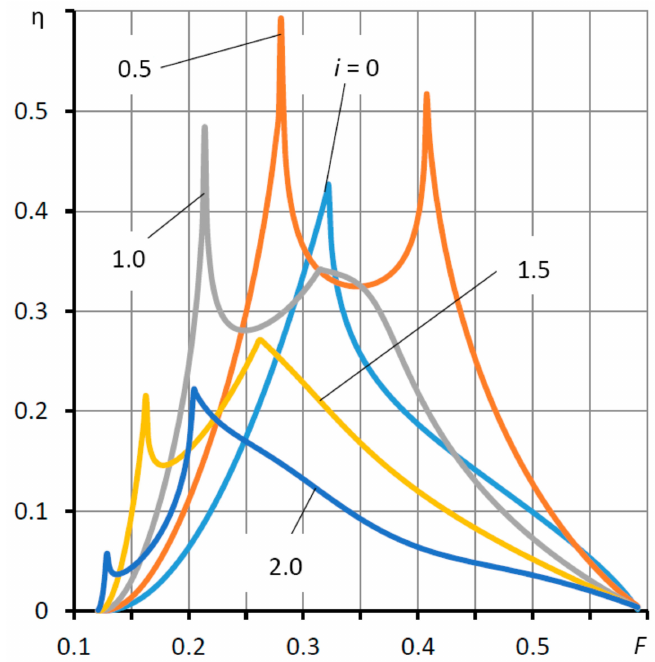
Figure 9. Dependences of the degree of stability η on load F for different values of the elasticity coefficient K e = i K e 0